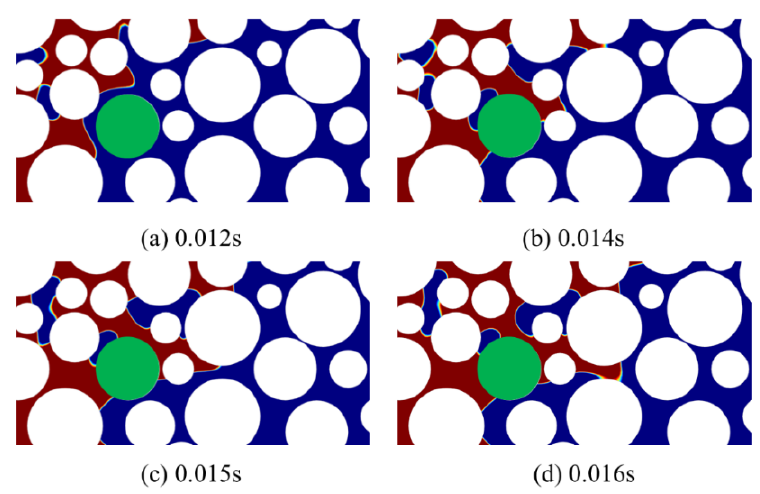
Figure 13. Under strong nonoil-wetted conditions, snapshots of fluid distributions in an enlarged section of the medium at four instants (contact angle = 120°, log Ca = − 4.25, log M = − 3.00). Red and blue regions represent CO 2 and oil, respectively.